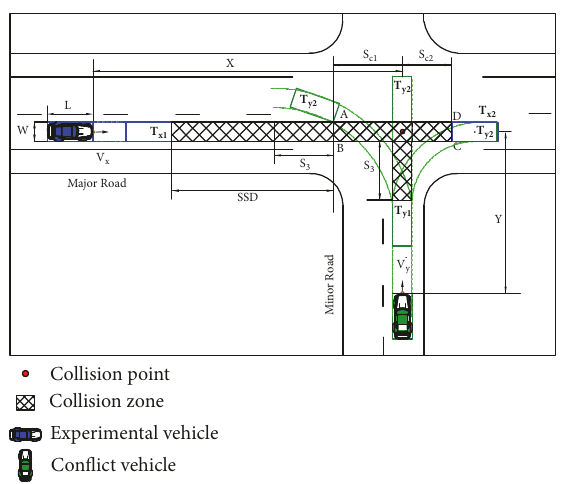
Figure 3: Intersection-collision zone.